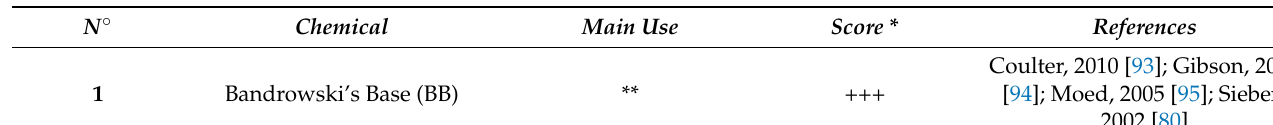
Table 1. Chemical allergens showing in vitro antigen-specific T cell activation in the different re- viewed